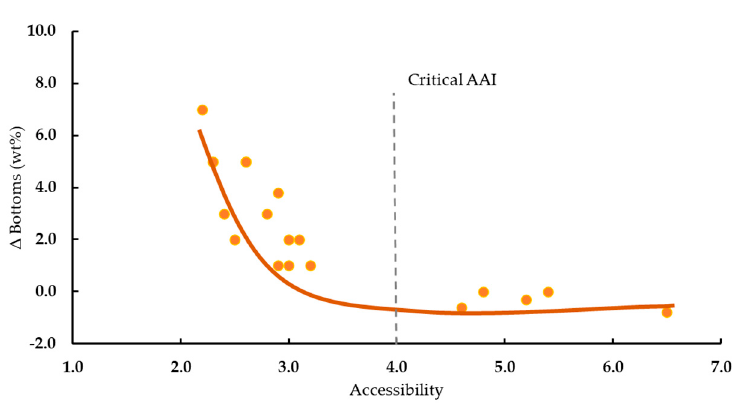
Figure 12. Effect of accessibility on bottoms conversion.